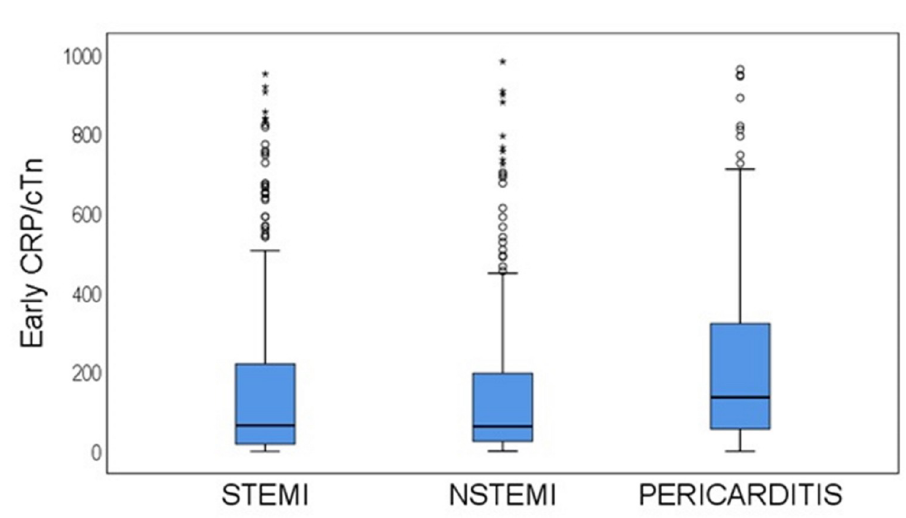
Fig 3. Box plot of CRP/troponin ratio for the 3 study groups after exclusion of outliners beyond a limit of 750. There is a clear distinction between the perimyocarditis group and all patients (STEMI or NSTEMI). CTR- CRP/ troponin ratio; other abbreviations are the same as in Fig 2.